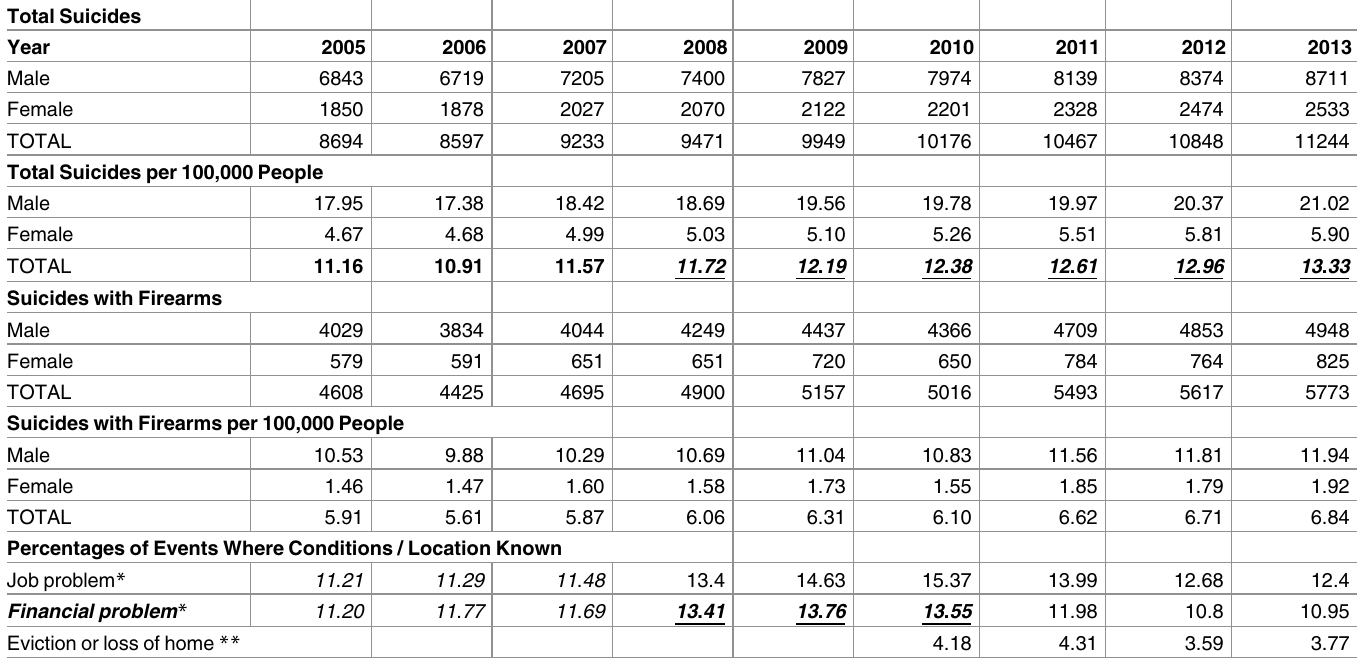
Table 3. Suicides data from the National Violent Death Reporting System (2005–2016 * ). The sixteen states participating in the NVDRS (of the CDC) are Alaska, Colorado,Georgia, Kentucky, Maryland,Massachusetts, New Jersey, New Mexico, North Carolina,Oklahoma, Oregon, RhodeIsland,